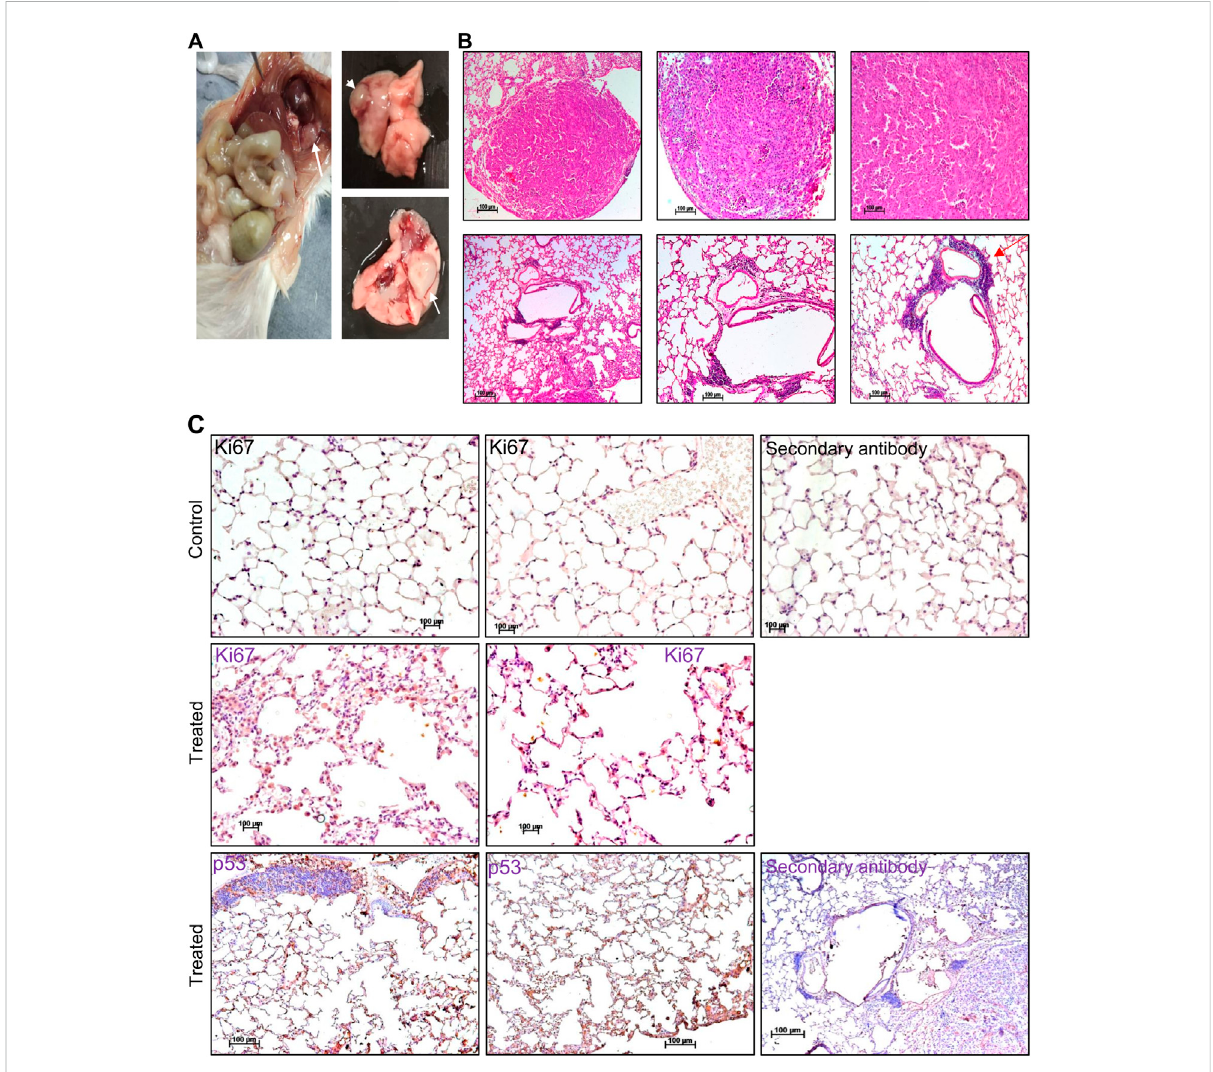
FIGURE 8 Histopathological examination of abnormal growth in lungs of mice post treatment with ES. (A) Abnormal growth was observed in the lungs following 16 months of ES exposure (5 mg/kg, 10 doses) in male mice. The white arrow indicates abnormal growth. (B) Histopathological analysis of abnormal growth in lungs from ES exposed male mice. The red arrow indicates the in fi ltrating cells (×5, ×10, and ×20). (C) Immunohistochemical analysis ofabnormal growth inlungs of ES exposed mice. Immunohistochemicalanalysisof control mice lung with Ki67 (toppanel) and treated micelungwithKi67andp53(bottompanel)(×20).Inpanels (B,C) experimentwasrepeatedthreeindependenttimesfromthetissuesofsameanimal. Control indicates lung tissue from untreated mice and treated indicates ES-treated tissue from male mice. Scale bar: 100 μ